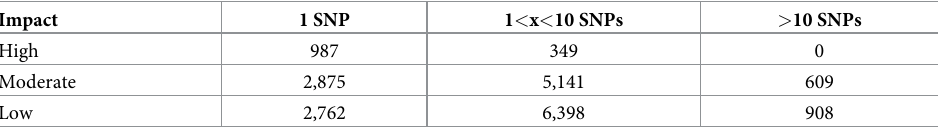
Table 3. Summary of SNPs present in the A . flavus NRRL 3357 genome when queried against the A . flavus AF70